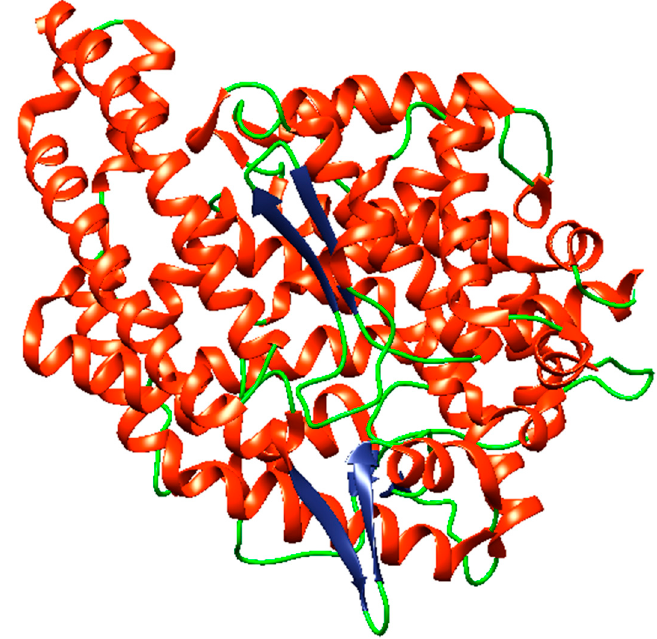
Figure 3. 3D structure of human ACE (PDB ID: 1o8A), visualized through CHIMERA.